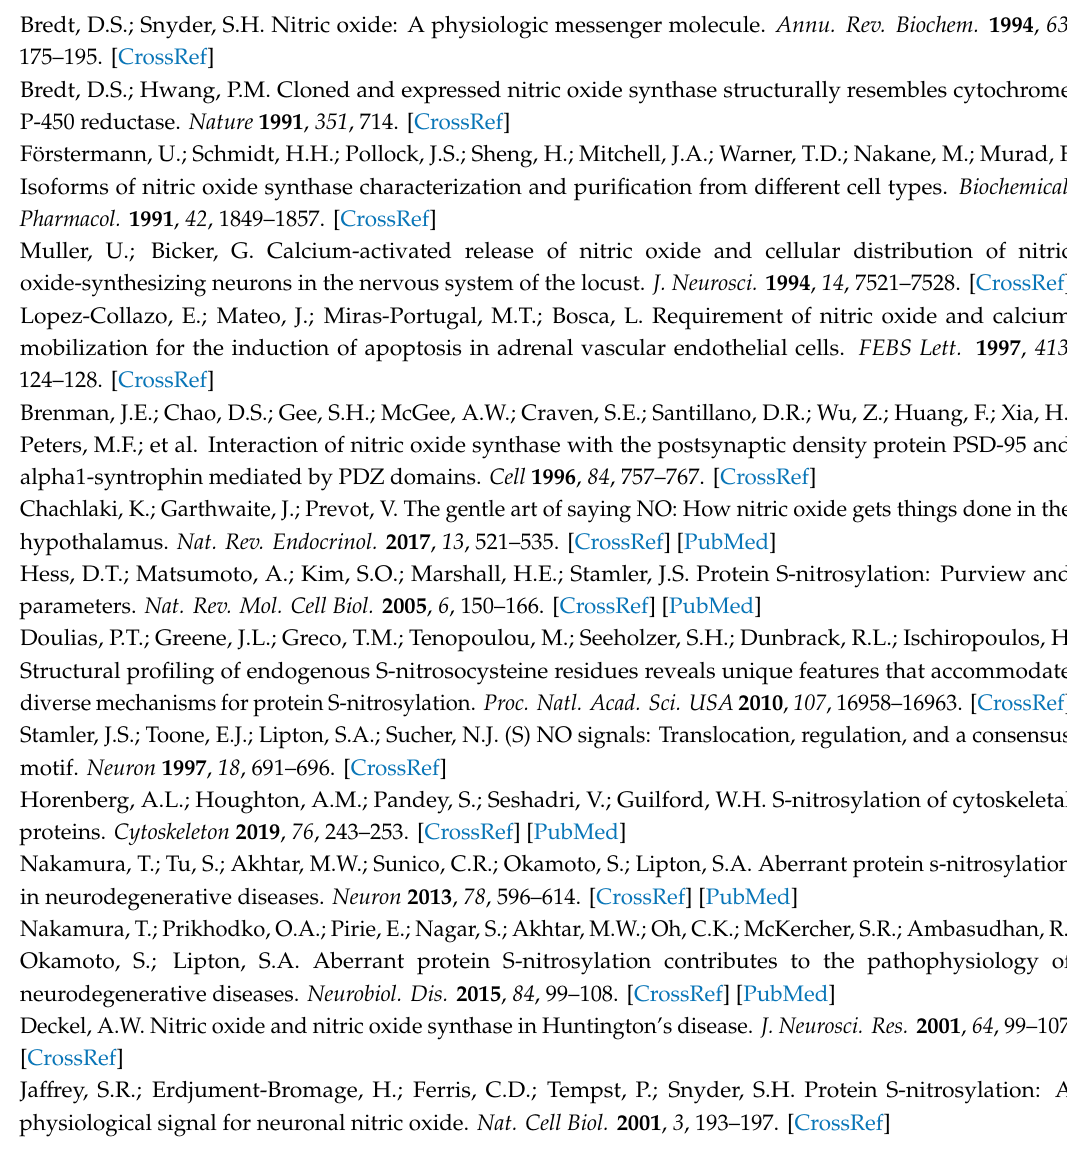
Figure S1. MF analysis was conducted on the SNO proteins that are found exclusively in the (A) female cortex and (B) male cortex groups. Each bar represents the − log10 of the FDR value. Figure S2. CC analysis was conducted on the SNO proteins that are found exclusively in the (A) female cortex and (B) male cortex groups. Each bar represents the − log10 of the FDR value. Figure S3. Proteins’ classification analysis of the SNO proteins that are found exclusively in the (A) female cortex and (B) male cortex groups. Figure S4. the SNOed kinases and phosphatases in the (A) female cortex and (B) male cortex groups. Table S1. IDs of SNO-proteins in the di ff erent groups. Table S2. System biology analysis of the female cortex group. Table S3. System biology analysis of the male cortex